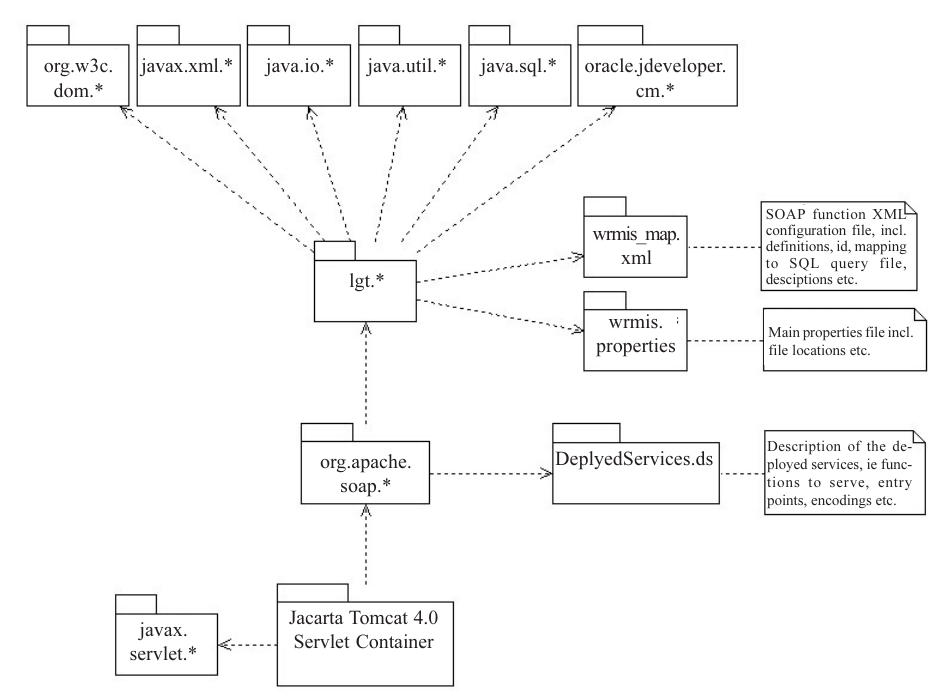
Fig. 4. Inner packages of Ground Water Web